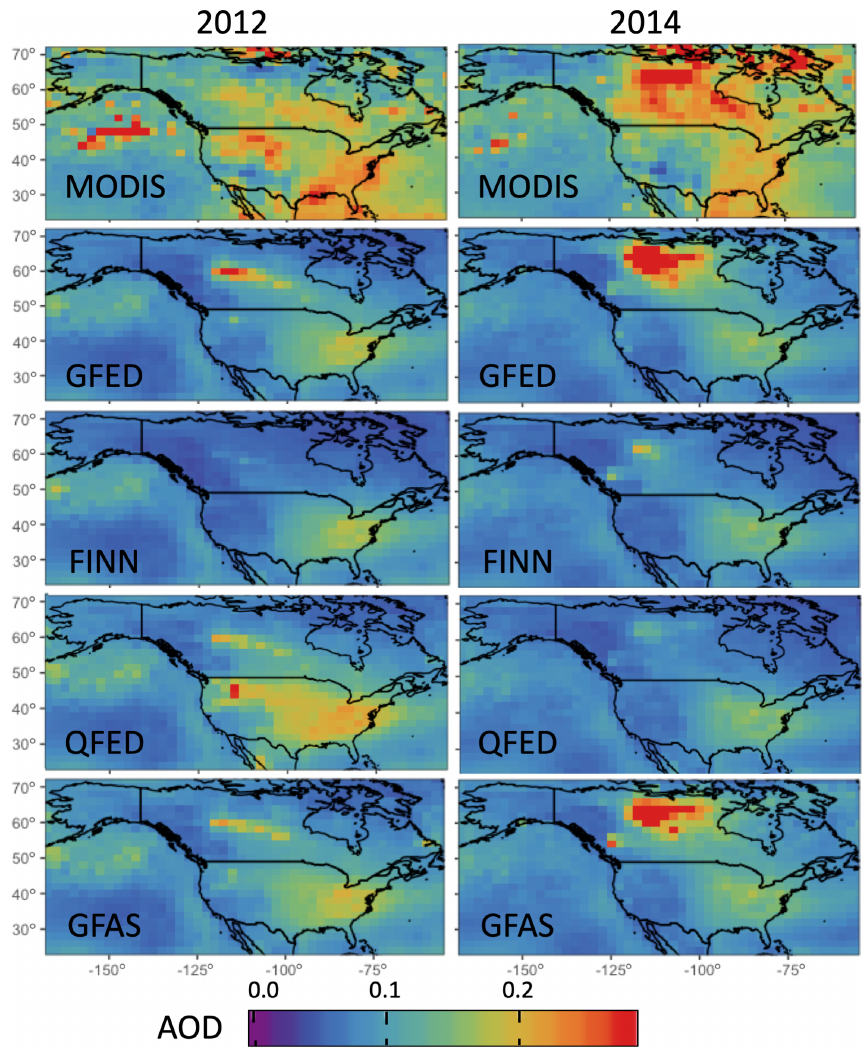
Figure 11. The mean Northern Hemispheric fire season (May–September) simulated AOD at 550nm sampled to and compared with daily MODIS-observed AOD from the Aqua satellite for 2012 and